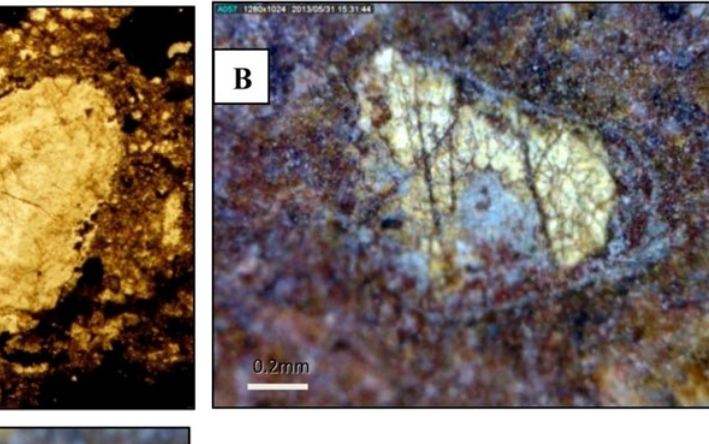
Fig. 6. K-feldspar in alkaline syenite. A. K- feldspar or albite in perthite, B. K-feldspar crystals fractured and the fractures filled with iron oxides, C. K-feldspar completely replaced by ore minerals and host REE